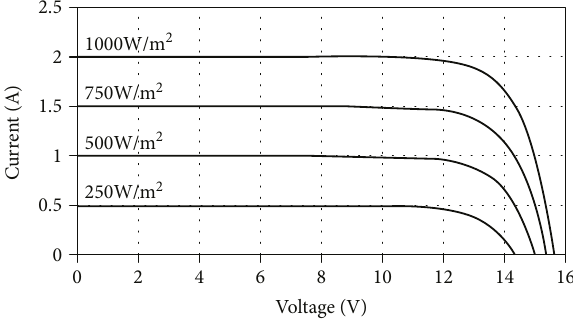
Figure 6: Current-voltage characteristic of solar PV